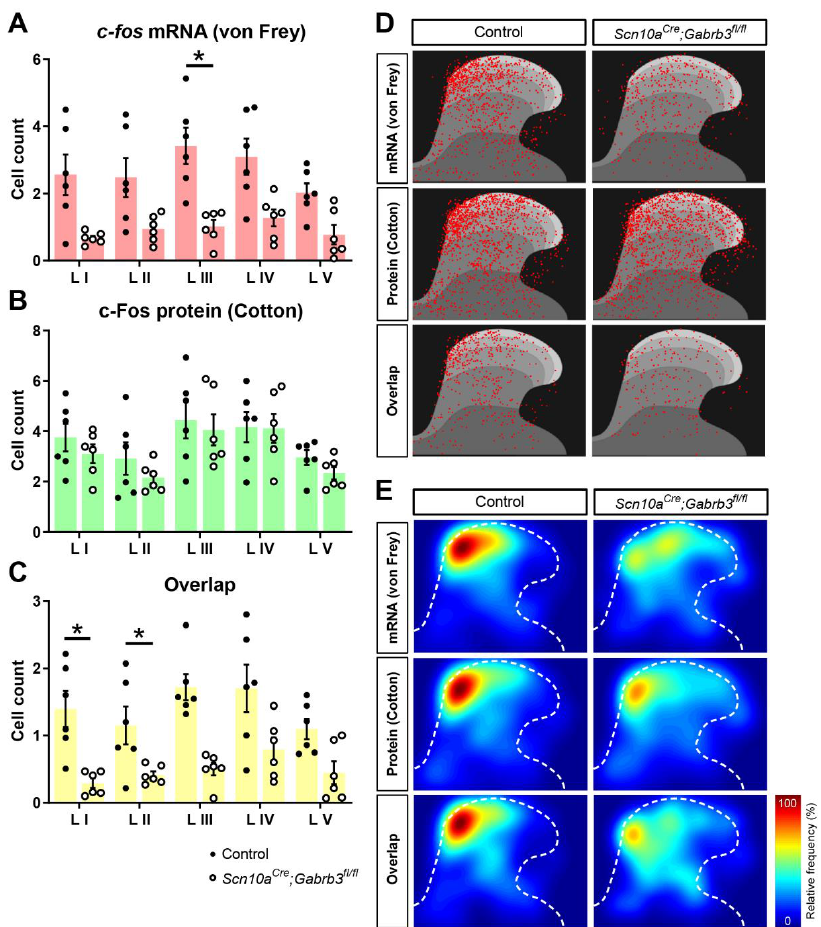
Figure 5. Distribution of cells positive for c-fos mRNA in response to punctate (red, von Frey, A ) and c-Fos protein (green, cotton, B ) mechanical stimulation across laminae I – V of the spinal dorsal horn for control mice (closed markers) and Scn10a Cre ; Gabrb3 fl/fl mice (open markers). The number of cells per mouse (cell count) labelled with both c-fos and c-Fos (yellow, overlap) are indicated in the lower panel ( C ). ( D ) Spatial location of cells positive for c-fos mRNA (upper, D ), c-Fos protein (centre, D ), and their overlap (lower, D ) after transformation onto a standard spinal dorsal horn with laminae I – V shown, respectively, in progressively darker grey tones for control mice (left column, D ) and Scn10a Cre ; Gabrb3 fl/fl mice (right column, D ). ( E ) Spatial density plot of the cellular distribution in panel ( D ) for c-fos mRNA (upper, E ) c-Fos protein (centre, D ) and their overlap (lower, D ) with spatial density increasing from blue through yellow to red for control (left column, E ) and Scn10a Cre ; Gabrb3 fl/fl mice (right column, E ). Data represent averages of 12 – 15 coronal slices per mouse from lumbar (L3 – L5) spinal dorsal horn using 6 mice per group. Values of p < 0.05 were considered significant and are indicated with asterisks as follows; * p < 0.05 .